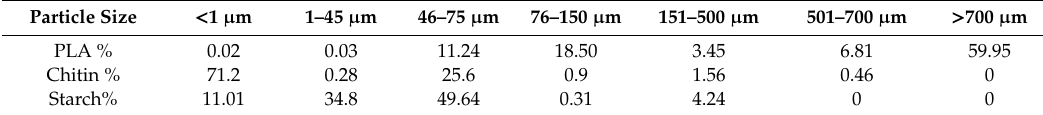
Table 1. Particle size distribution. PLA = poly(lactic acid).